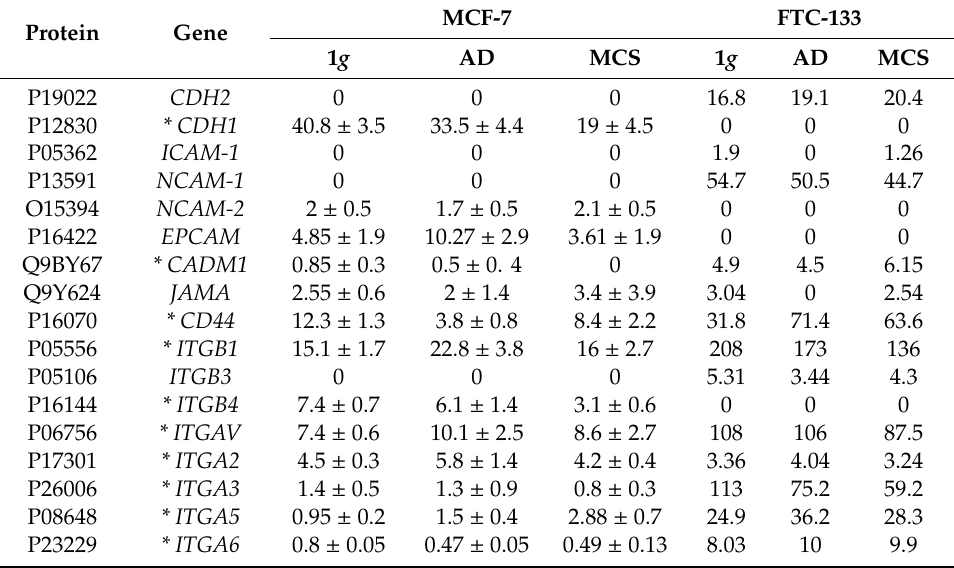
Table 1. Proteins of MCF7 and FTC-133 cancer cells cultured under normal gravity (1 g ) or under simulated microgravity as adherent (AD) or as aggregated cells (MCS). The proteins were selected from recent proteome analyses [5,6] because their sialylation is described in the literature. UniProt accession numbers, genes, and label free quantitation values (LfQ) are